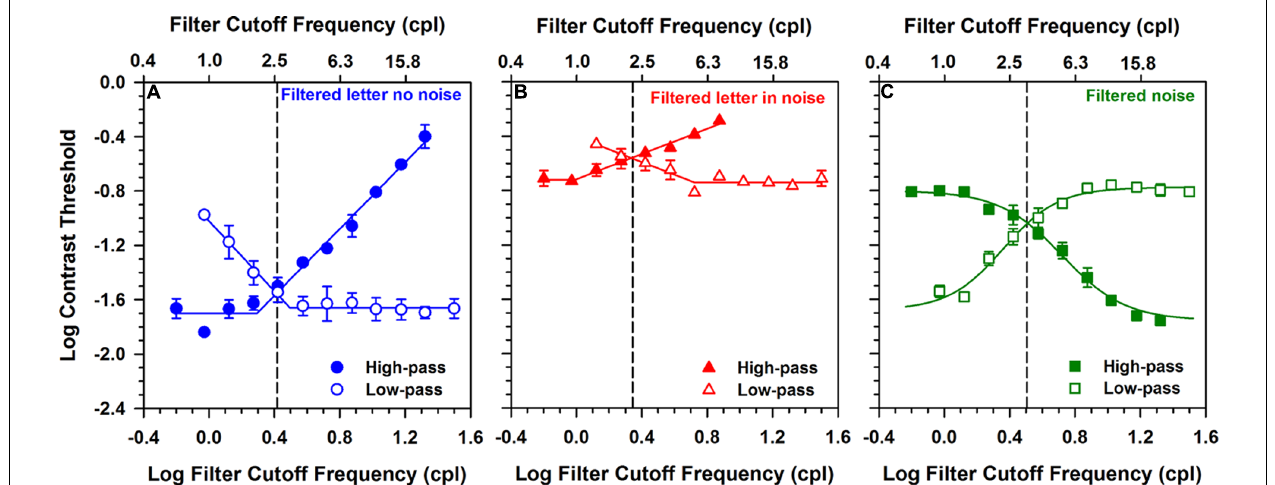
bars represent ± 1 (SEM), which are omitted when smaller than the data points.The solid lines in the left and middle panels represent piecewise linear fits to the data, whereas the solid lines in the right panel represent the function described by Majaj etal. (2002).The dashed vertical lines indicate the point at which the two functions crossed, which was used as the index of the center object frequency in the following figures.